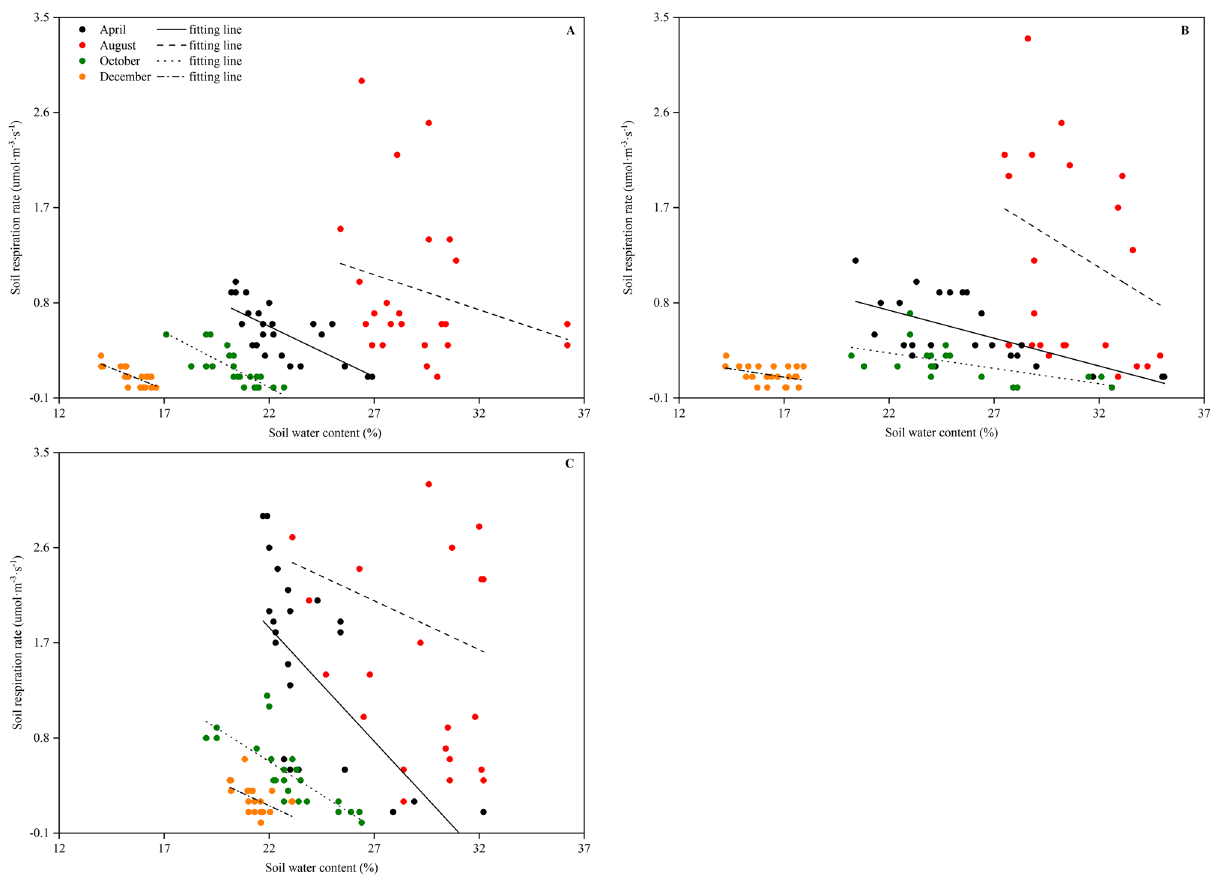
Figure 4. Relationships of daytime soil respiration in April, August, October and December with soil water contents at the CK (A) , CT (B) and WM (C) sites. Different types of lines are the linear fits for different months. CK, natural coastal wetland; CT, cotton mono-cropping farmland; and WM, wheat–maize rotation cropping